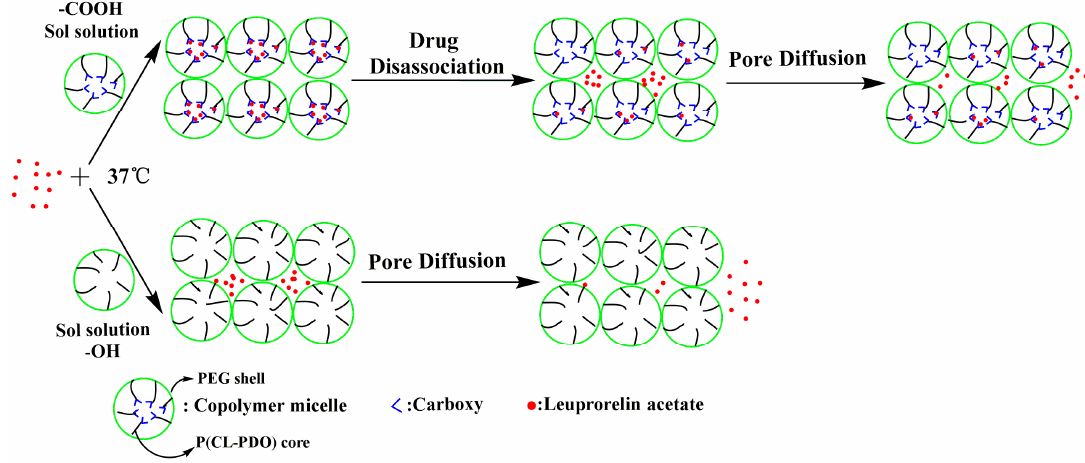
Figure 1. Comparison of release mechanisms for hydroxyl terminated (–OH) and carboxylic terminated (–COOH) PECP hydrogels loaded with leuprorelin acetate.